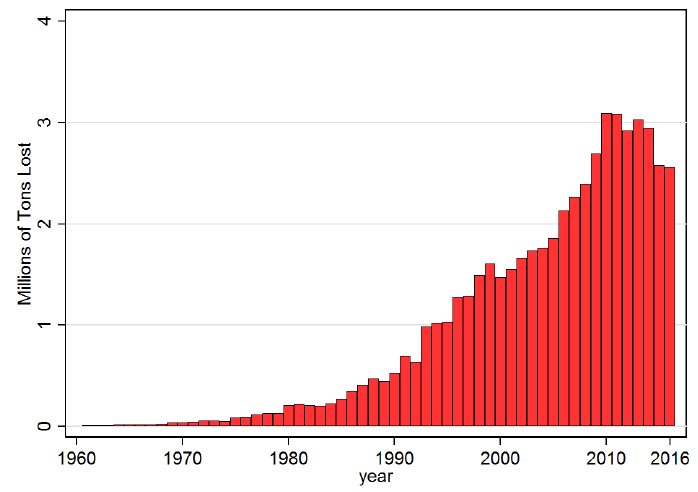
Figure 7. Potential Losses. Note: This figure provides the total predicted losses as estimated from the linear regression model in Equation